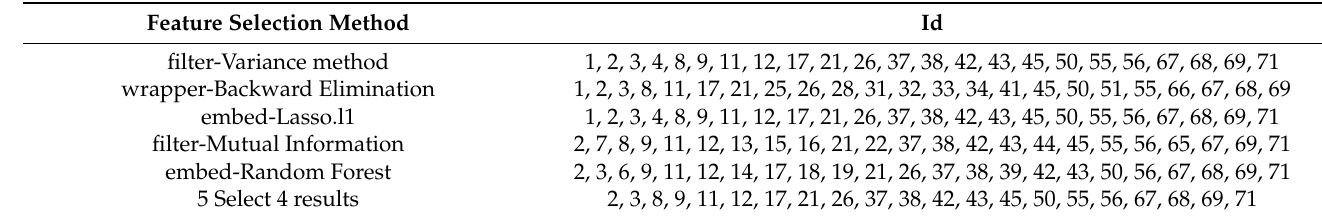
Table 2 below shows the feature selection algorithm’s processing of variance, mutual information from filter, backward elimination from wrapper and Lasso.L1, and random forest from embedded for the feature selection method of the top 25 features selected. Table 2. Feature selection algorithm